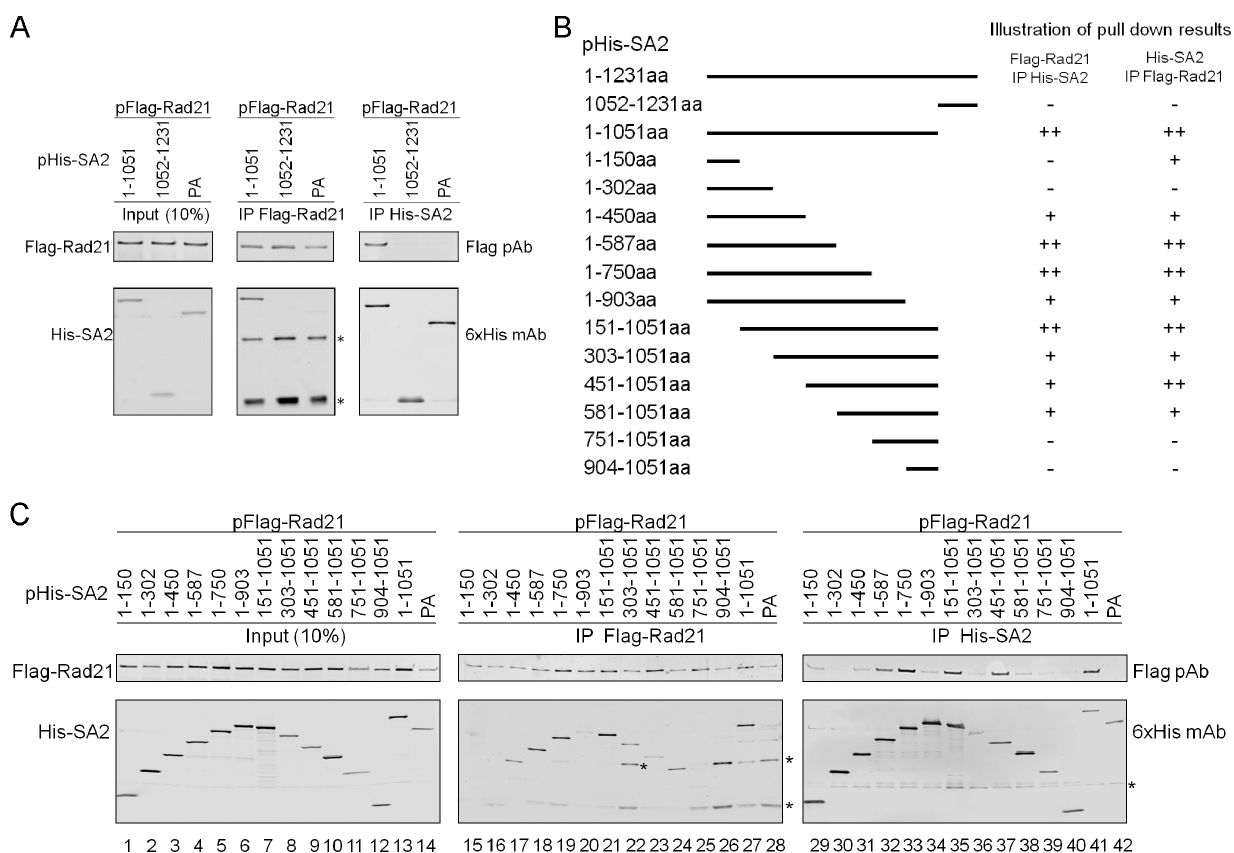
Figure 1. Characterization of the interaction between Rad21 and SA2 mutants. ( A ) Rad21 interacts with SA2 (1–1051 aa). Rad21 was co- expressed with either SA2 (1–1051 aa) or SA2 (1052–1231 aa) in Sf21 cells and co-purified by Ni-NTA or Flag beads. Rad21 co-expressed with the influenza A virus PA protein was used as a control. Western blot analysis was carried out using either the Flag polyclonal antibody (pAb) or the 6xHis monoclonal antibody (mAb). IgG bands are marked by asterisks (*). ( B ) Left panel shows the schematic illustration of the design of the SA2 deletion mutants used in (C). Right panel indicates the relative interaction strength of Rad21 and SA2 mutants in (C). ++ : strong interaction; + : weak interaction; 2 : no interaction. ( C ) Flag-tagged Rad21 WT was co-expressed with His-tagged SA2 deletion mutants and co-purified by Ni-NTA or Flag beads. The influenza A virus PA was used as control. Nonspecific bands due to antibody cross-reaction are marked by asterisks (*).